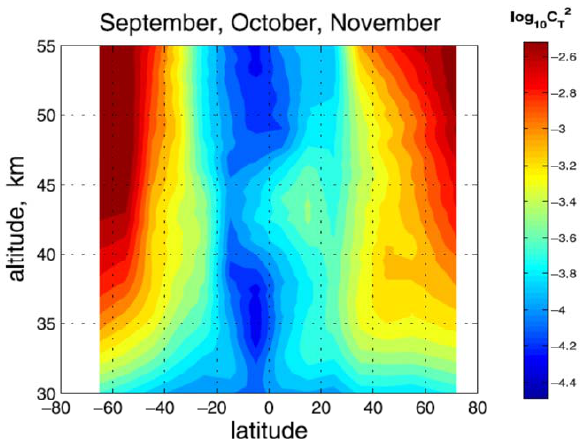
Fig. 52. Zonal averaged C T2 (K 2 m -2/3 ) in one season, which covers the end of southern winter pole (September) and the beginning of Northern winter pole (November) logarithmic color scale. It shows the large increase of C T2 in both winter poles, connected to the polar night jet. The four seasons are displayed in Gurvich et al. (2007).